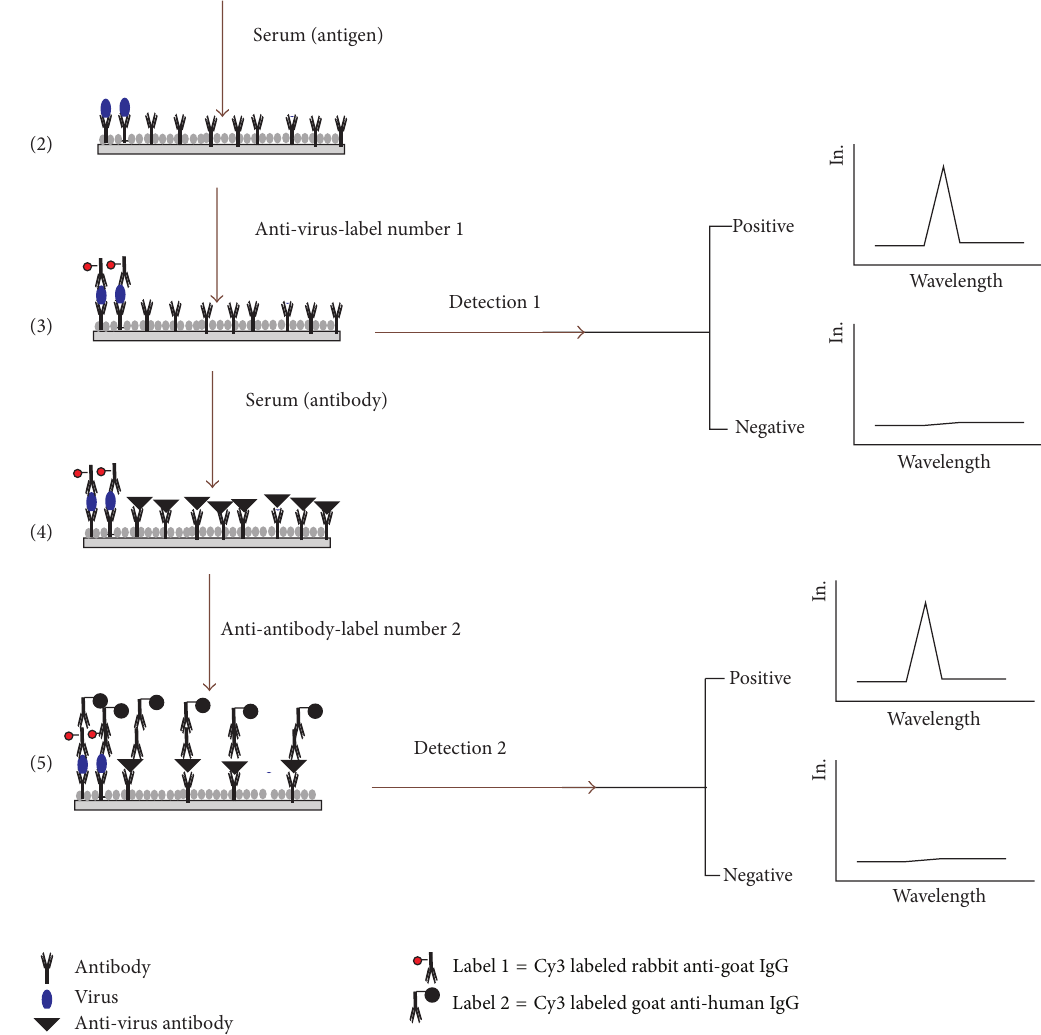
Figure 4: The scheme of this model diagnostic strategy and its operation procedures.